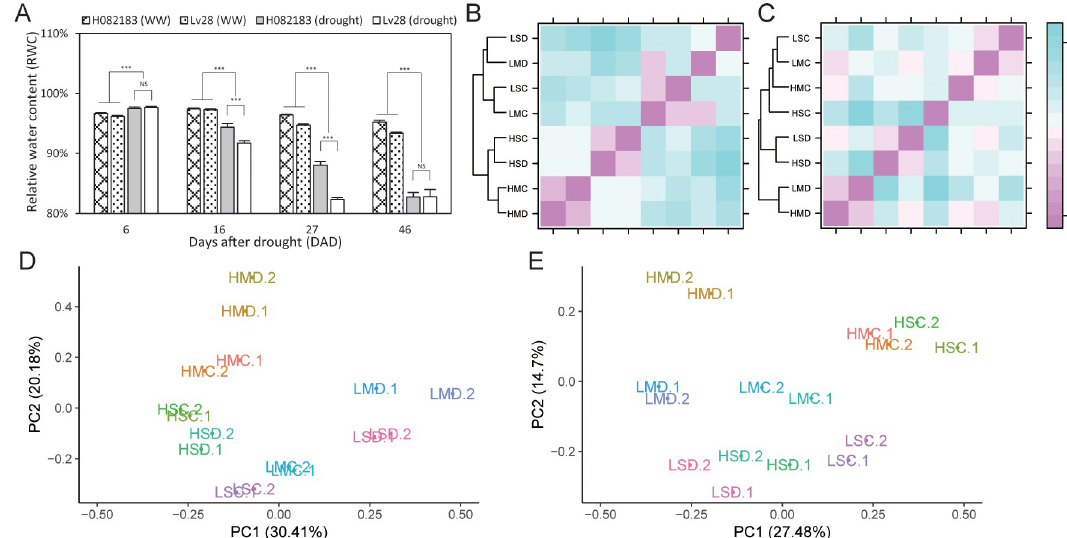
Fig 1. The change in leaf relative water contents under drought and the sample relationship based on the miRNome results. (A) The leaf relative water contents (RWCs) of H082183 and Lv28 under drought and well-watered treatments. �� : P < 0.01; � : P < 0.05; NS: P > 0.05. (B) Cluster analysis of miRNome of leaf samples. (C) Cluster analysis of miRNome of root samples. (D) Principal component analysis (PCA) of leaf samples. (E) PCA of root samples. HMD: H082183 under moderate drought, HSD: H082183 under severe drought, LMD: Lv28 under moderate drought, LSD: Lv28 under severe drought. HMC: H082183 under moderate drought control, HSC: H082183 under severe drought control, LMC: Lv28 under moderate drought control, LSC: Lv28 under severe drought